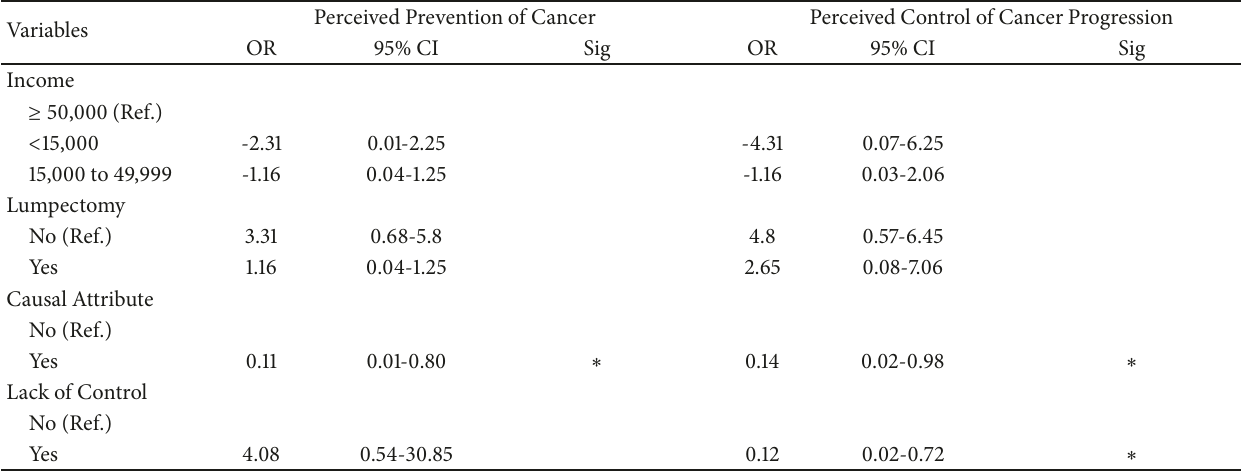
Table4:Oddsratiosand95%confidenceintervalsfrommultinomiallogisticregressiononperceivedcancerpreventionandperceivedcontrol of cancer